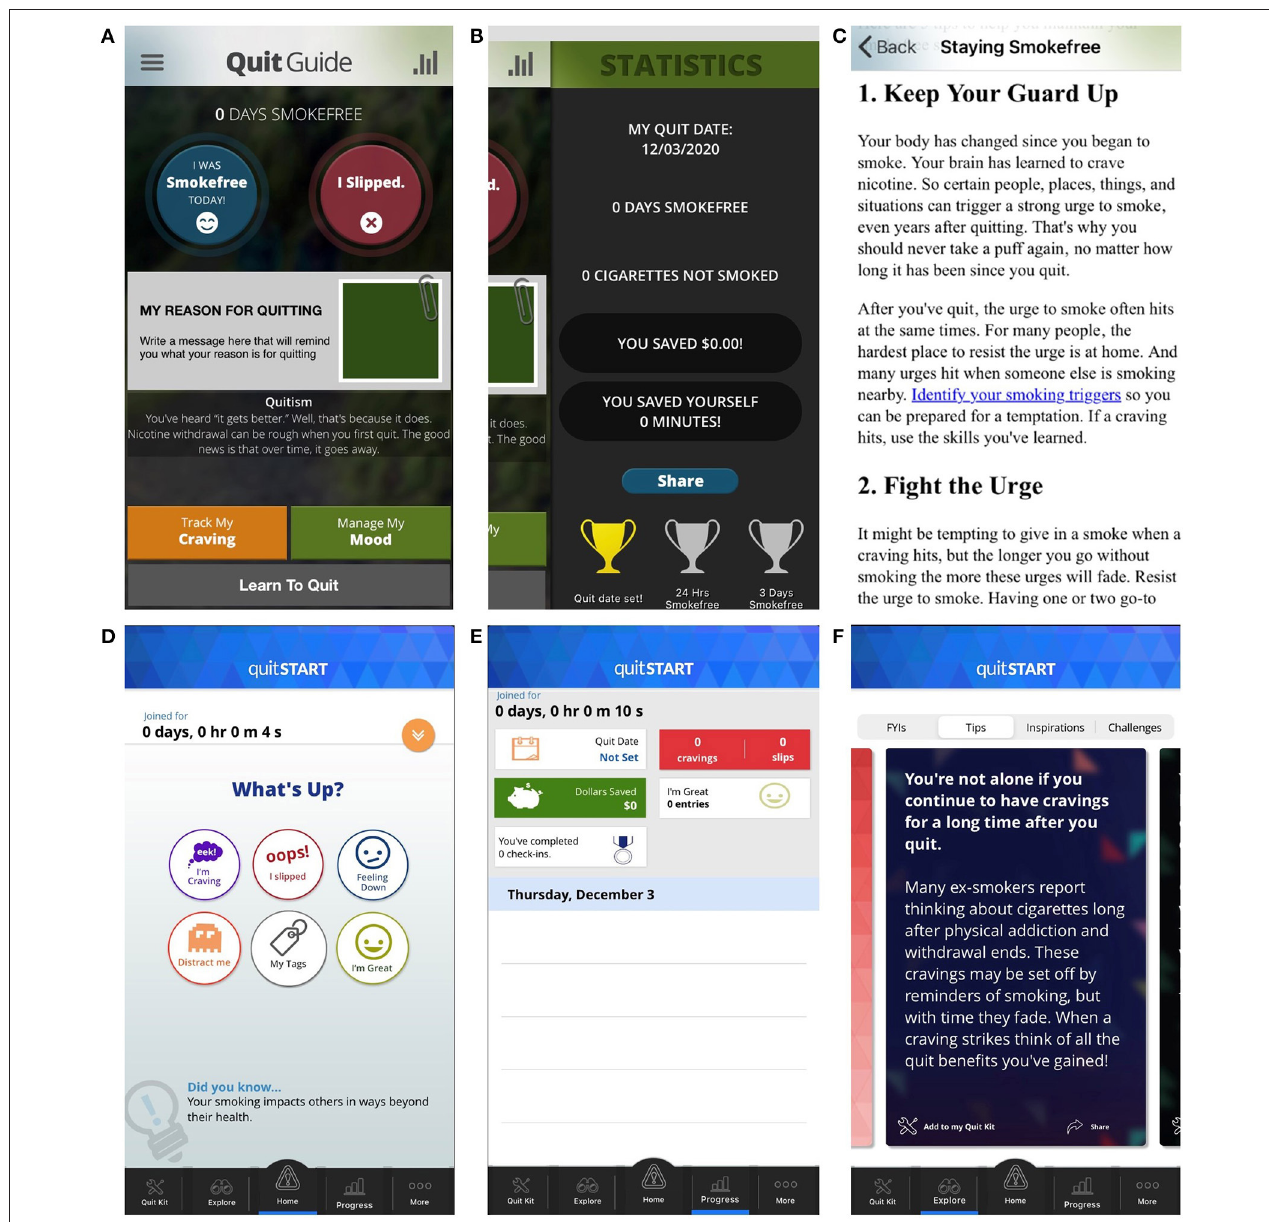
FIGURE 1 | Selected Screen Shots from QuitGuide (A–C) and quitSTART (D–F) . Represented here are the home screens (A,D) , progress screens (B,E) , and information on how to quit smoking (C,F) .